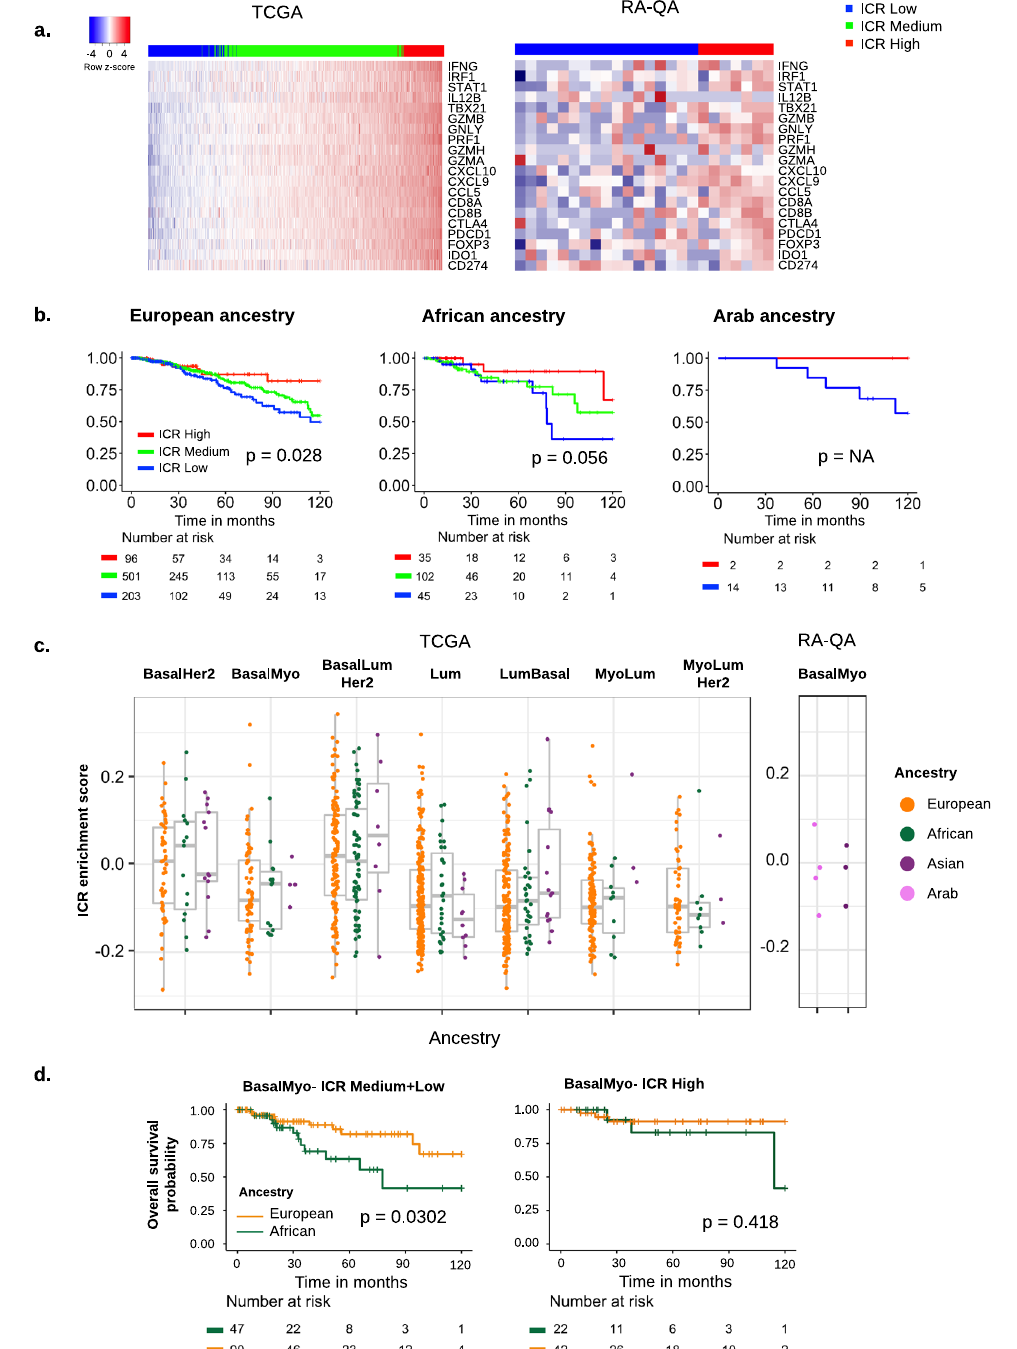
Fig. 2 Tumor immune phenotypes and clinical outcome by ancestry. a Heatmap of ICR gene expression in TCGA and RA-QA breast cancer cohorts. Classi fi cation of samples by ICR consensus clustering segregates TCGA samples in ICR low, ICR medium, and ICR high groups. Samples of RA-QA cohort were classi fi ed as ICR low or ICR high. b Kaplan – Meier plots showing overall survival across ICR groups in breast cancer TCGA patients of EA (left), TCGA patients of AA (middle), and RA-QA patients of ArA (right). c ICR enrichment scores across ancestries within TDA signature classes. Box plots indicate medians and interquartile range, and whiskers represent 10th and 90th percentile. All data points are plotted individually. d Overall survival of EA and AA patients in TCGA BasalMyo samples classi fi ed as ICR medium + low (left), and ICR high (right). Censor points are indicated by vertical